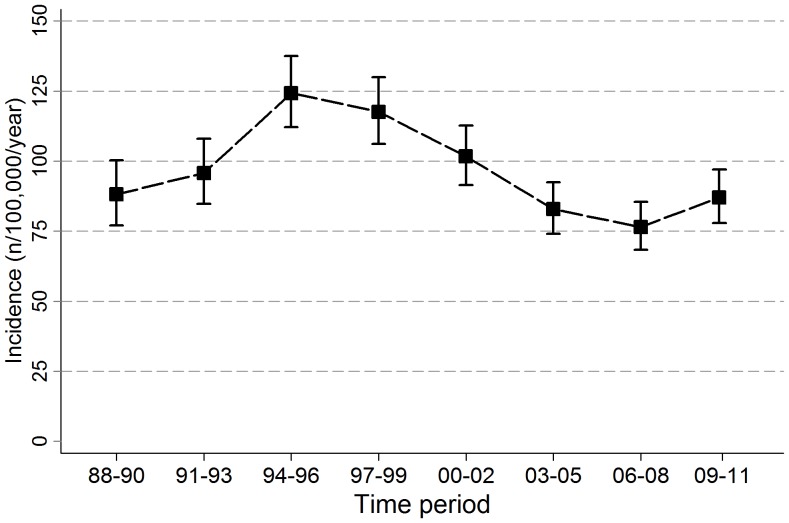
Incidence of new smear-positive pulmonary TB in Karonga District in adults.Error bars indicate 95% confidence intervals.